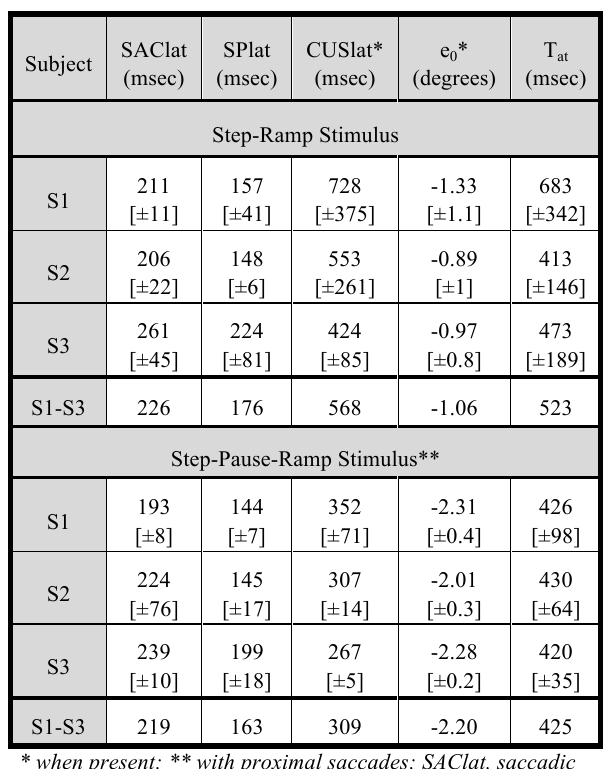
Table 1. Average Latencies, Errors and Acquisition Times